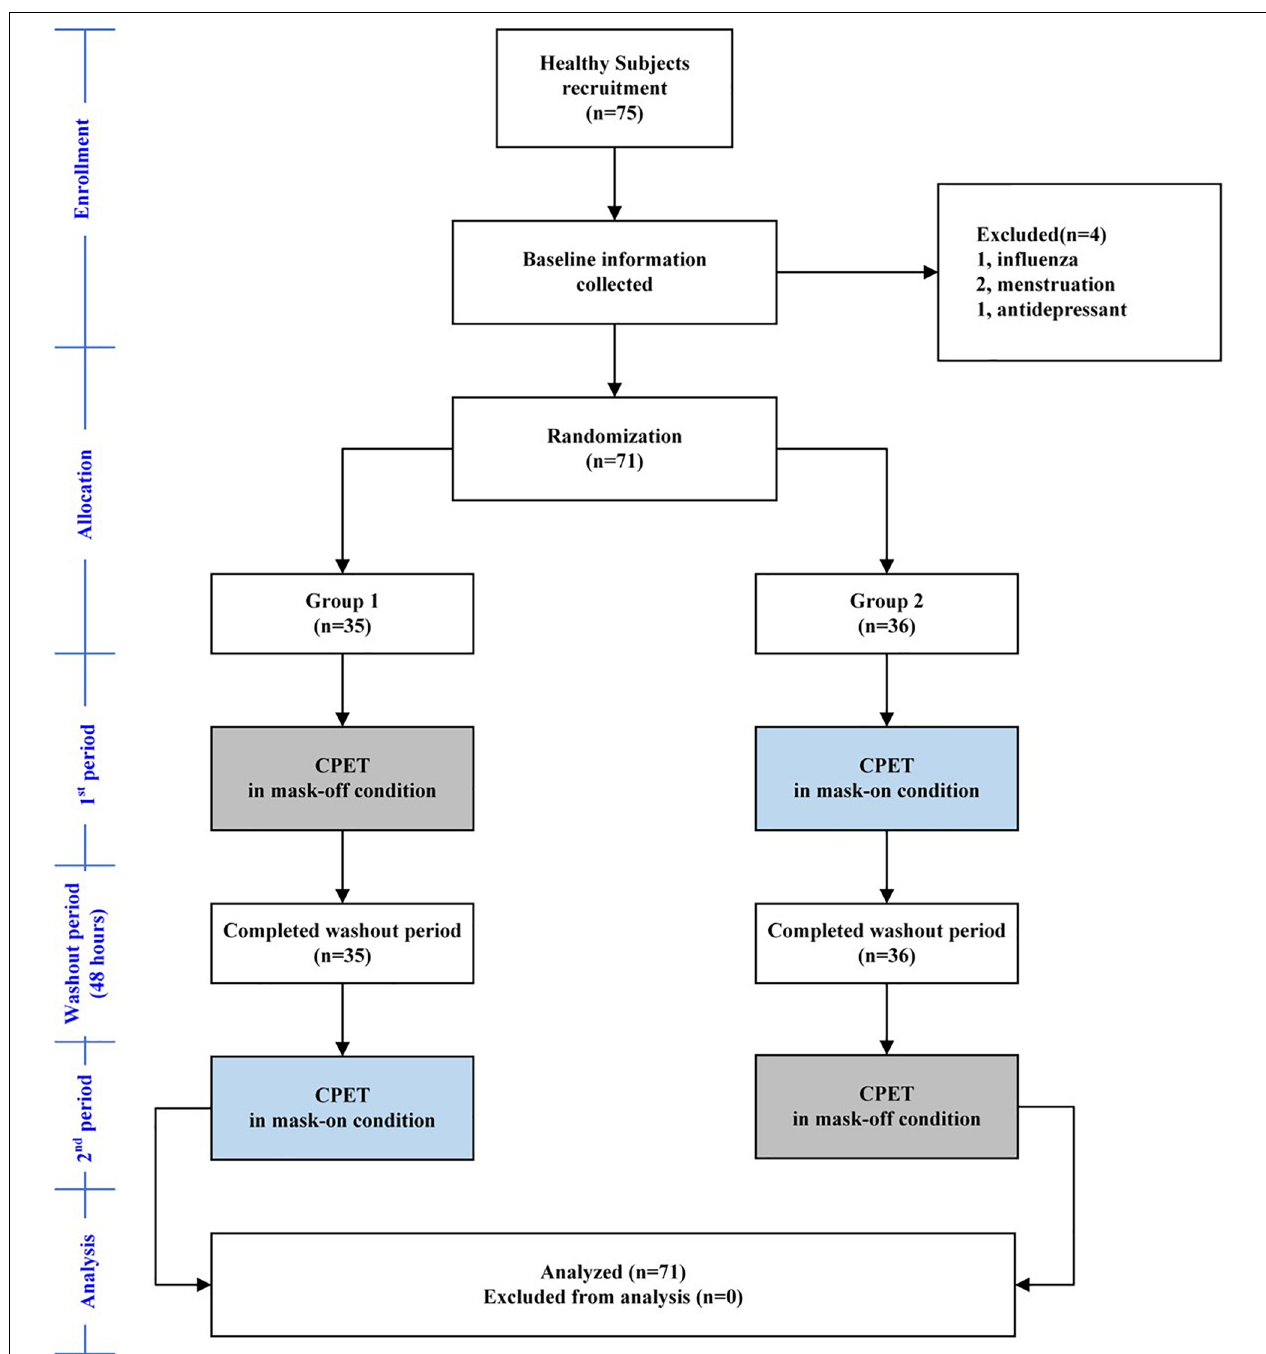
FIGURE 1 | The study flow diagram.